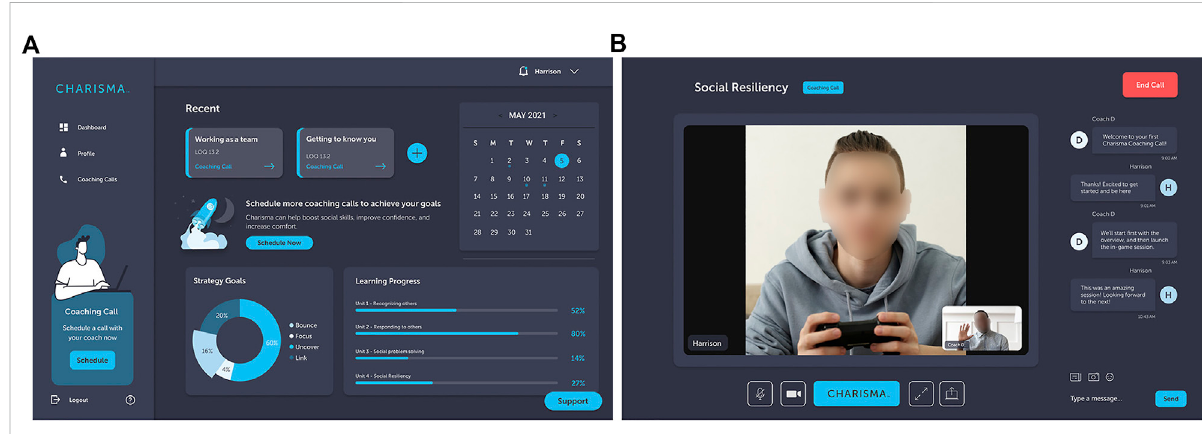
FIGURE 9 Charismadigitalhealthplatform. (A) Thedashboarddisplayspreviousandupcomingsessions. (B) Thecoachandclientmeetusinganintegrated audio-video conferencing